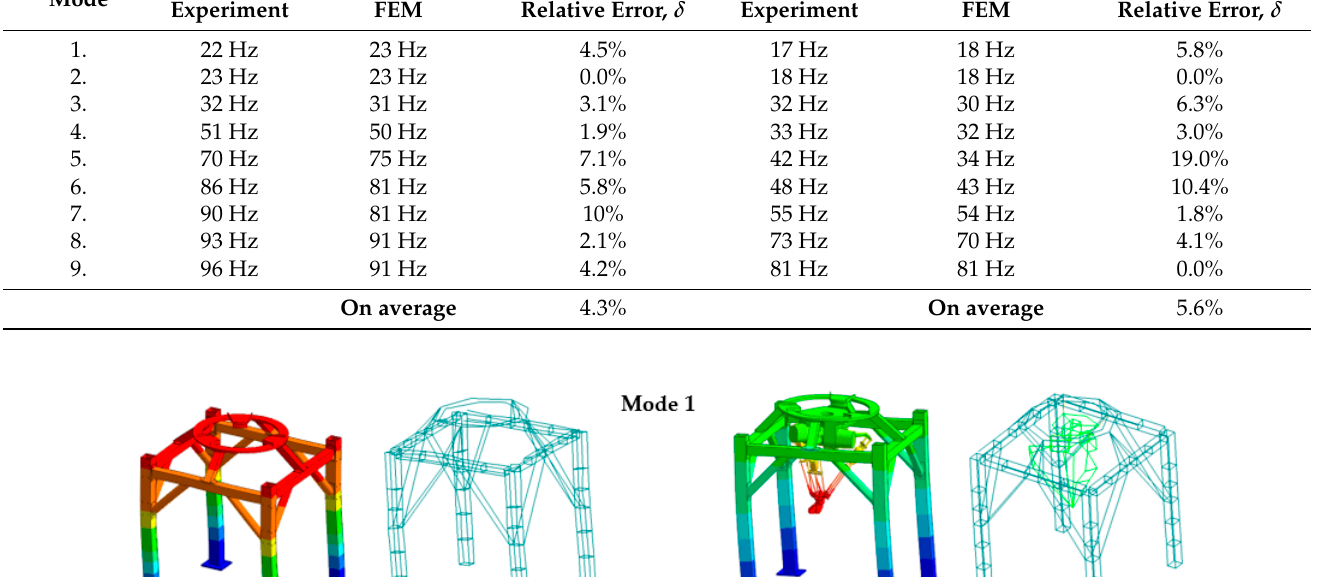
Table 2. Experimental verification of the natural frequencies of the frame and the frame with the robot.